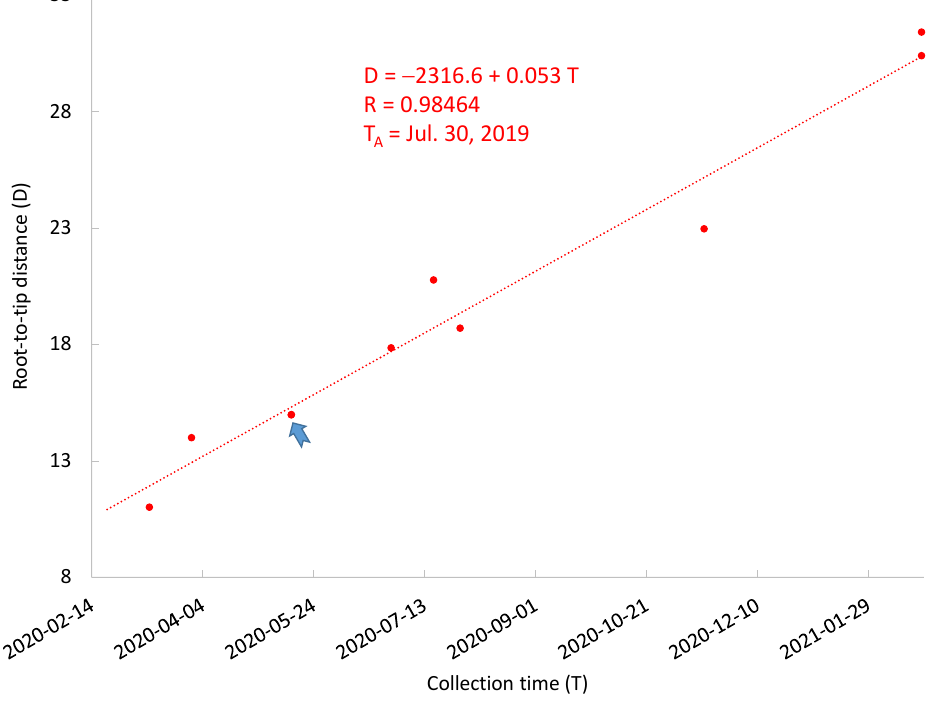
Figure 4. The relationship between root-to-tip distance (D) and SARS-CoV-2 collection time (T) for non-human samples. A regression line is fitted to 10 samples from 10 infected cats (red dots). The blue arrowhead points to two overlapping red dots. The ancestor of cat SARS-CoV-2 was dated 30 July 2019.